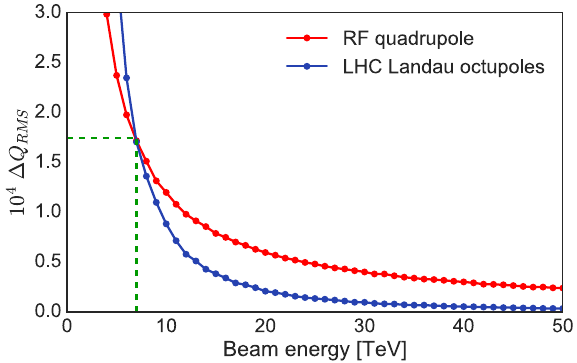
FIG. 5. Dependence of the RMS tune spread on the beam energy for both LHC magnetic octupoles at maximum strength (blue) and for an rf quadrupole (red), designed in such a way as to produce the same RMS tune spread at 7 TeV (green dashed